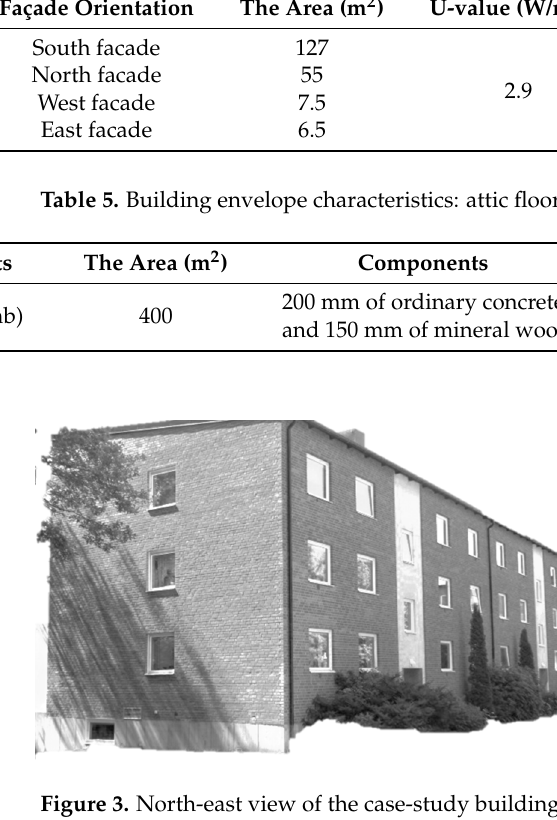
Table 4. Building envelope characteristics: windows.